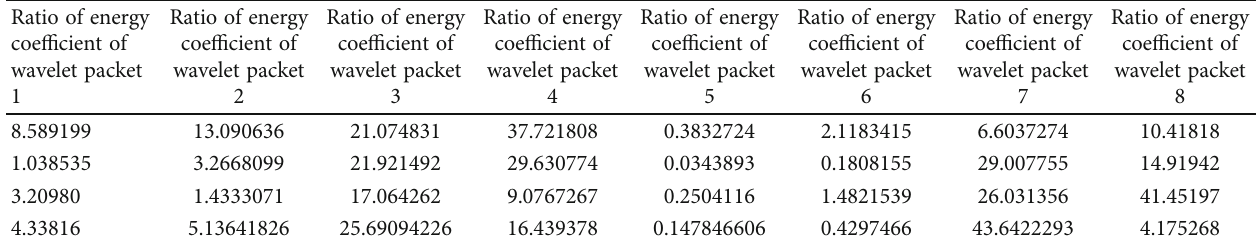
Table 3: The ratio of energy coe ffi cients of wavelet packets in each frequency band.